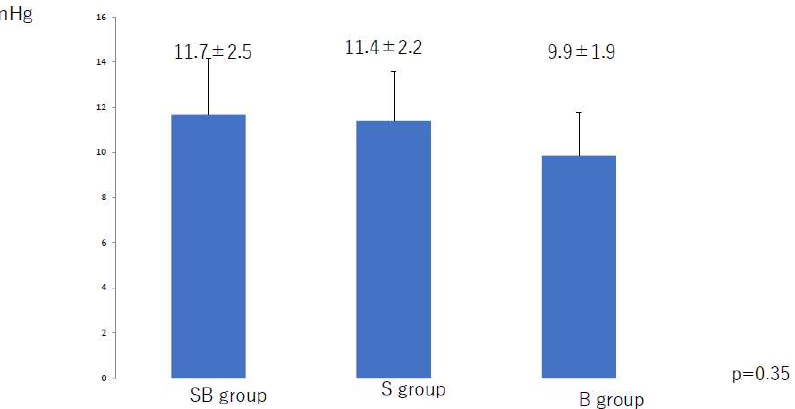
Figure 5. Mean compression applied to the thigh after a decrease in pressure at 6 months after lipo- suction. B, bandage only; SB, compression stocking and bandage; S, stocking only.